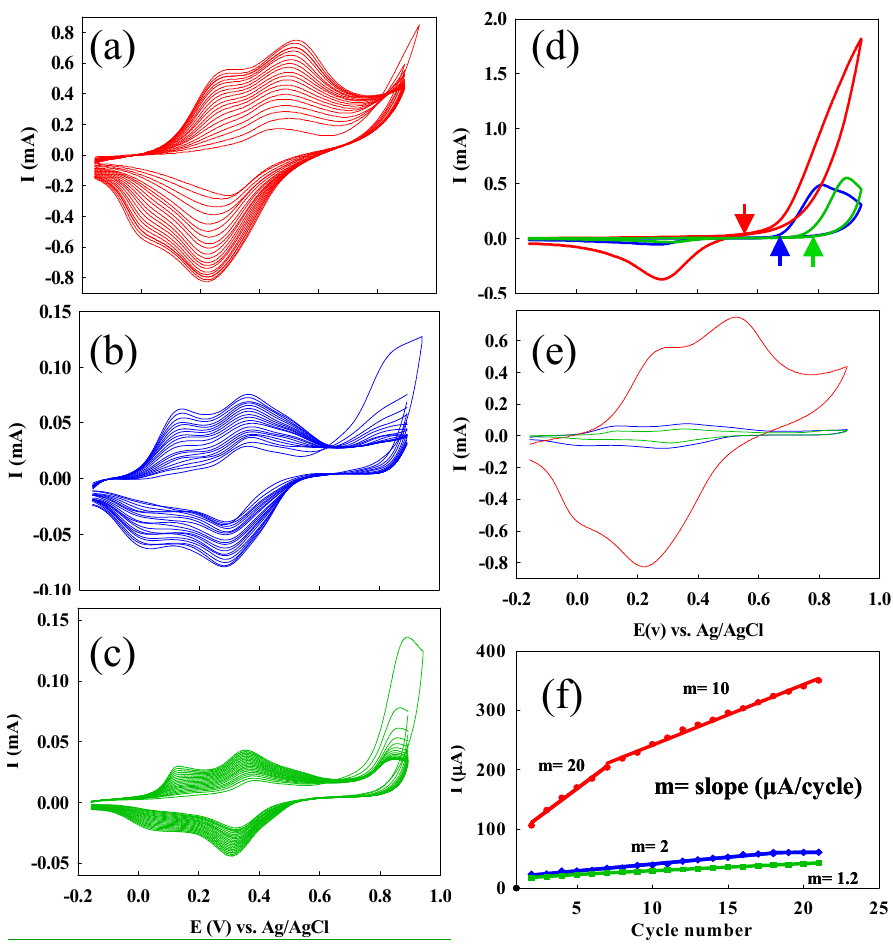
Figure 1 . Cyclic voltammograms recorded during the electropolymerization of 3- aminophenylboronic acid on electrodes from the second cycle to 21st cycles at (a) ss- DNA/SWNT-modified (b) 2-aminoethanethiol- SAM-modified, and (c) double stranded- DNA-modified gold electrodes. Potential scan rate: 100 mV s -1 . (d) The first cycles of the cyclic voltammograms in (a), (b) and (c). (e) The last (21 st ) cycles of the cyclic voltammorams in (a), (b) and (c). (f) The faradic current of the second oxidation peak of PABA on the modified electrodes as a function of cycles. (m is the slope of the fitted lines, in  A/cycle units.) (Reproduced with permission from the American Chemical Society